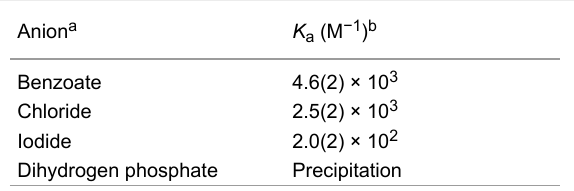
Table 1: Anion association constants for 5 · 2PF 6 calculated by using WINEQNMR2 [13] based on 1 H NMR titration data (500 MHz, 293 K, CD 3